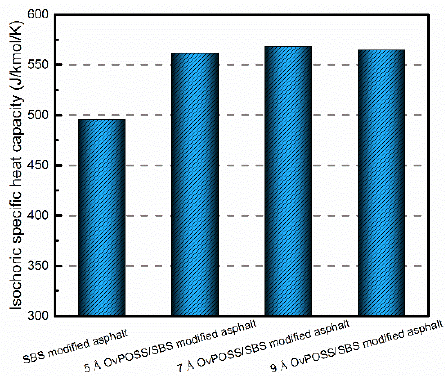
Figure 17. The isochoric specific heat capacity of modified asphalt.